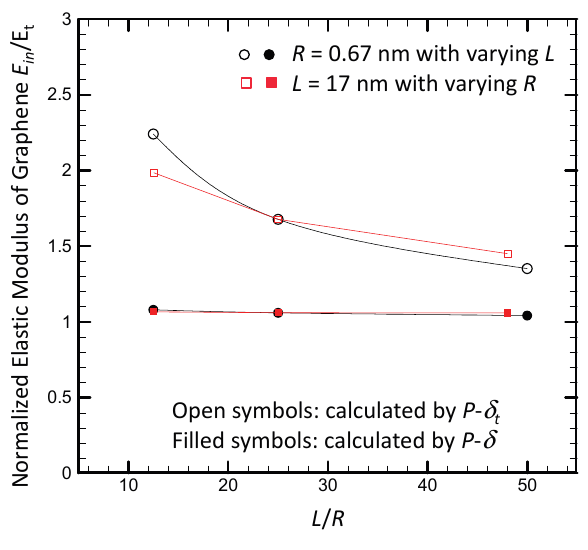
Figure 7. Elastic modulus of monolayer graphene ( E length to indenter tip radius ( L / R ), displayed as the ratio of E monolayer graphene determined from in-plane tension.